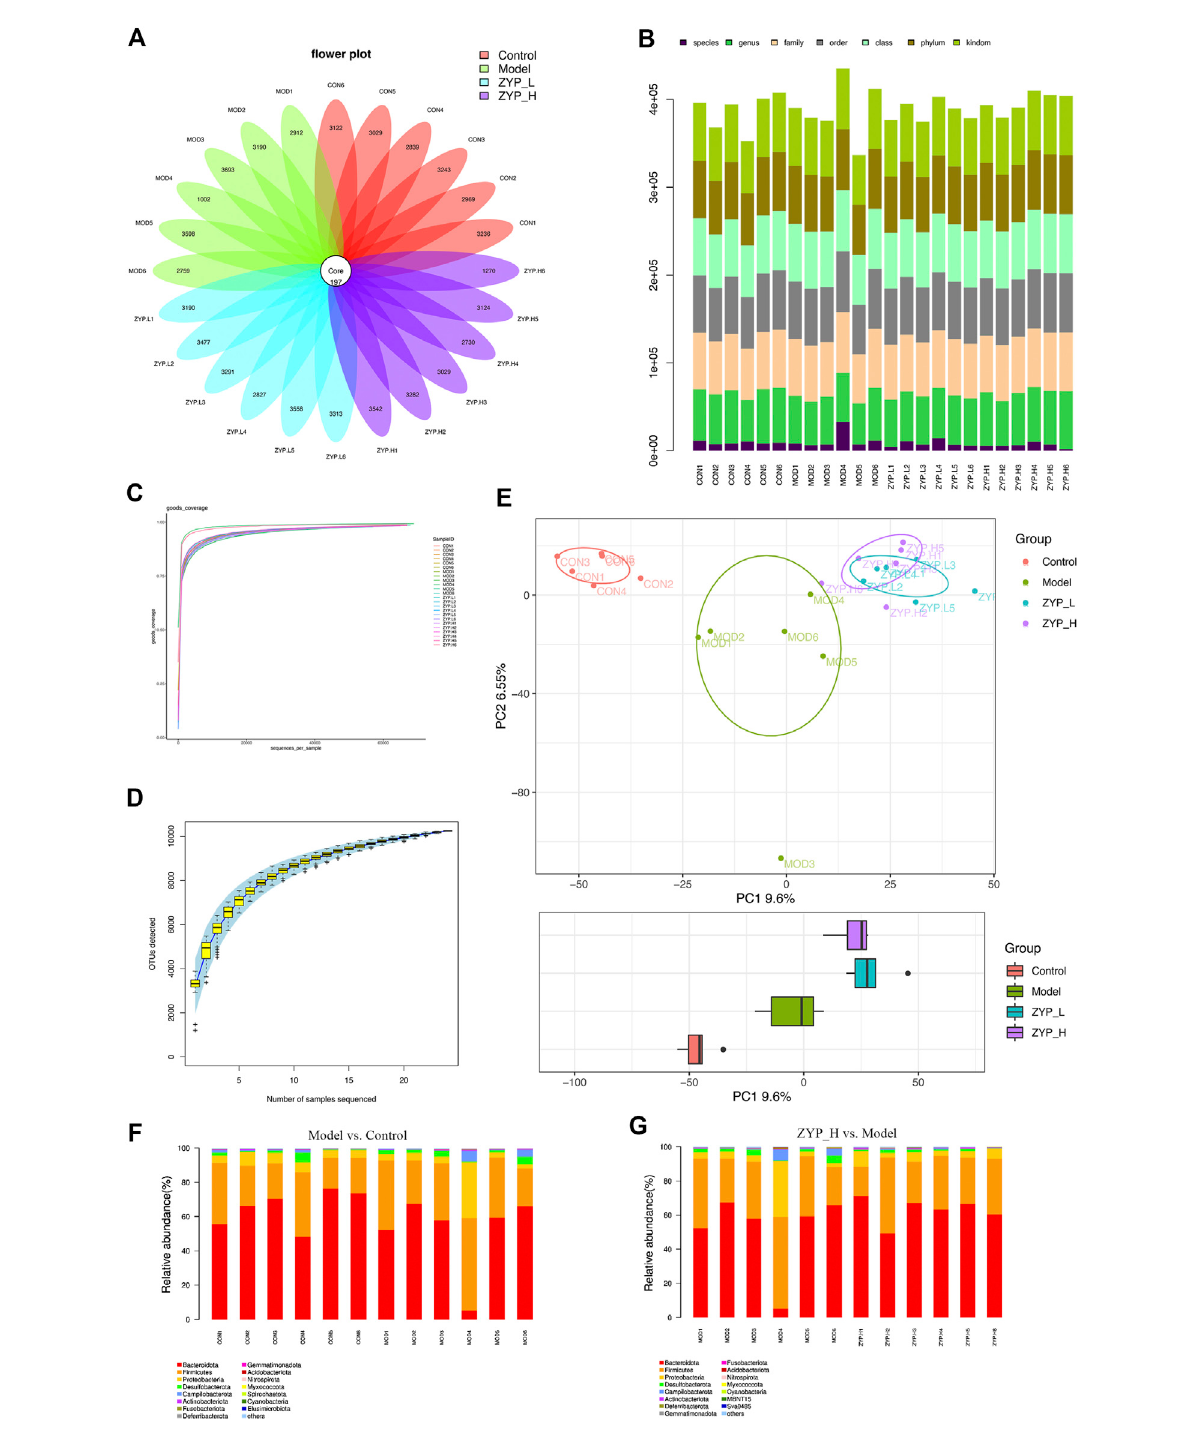
FIGURE 4 Classi fi cation of OTUs, alpha-diversity analysis, and beta-diversity analysis. (A) Operational taxonomic units (OTUs)-based petal maps. Each petal corresponds to a sample group, with the shared overlapping region representing OTUs common to all samples, and the numbers on individual petals representing the number of OTUs unique to a given sample group; (B) Comment situation of tags; (C) Curve of diversity index dilution; (D) Curve of SAC; (E) PCA analysis; (F,G) Relative abundance at phylum